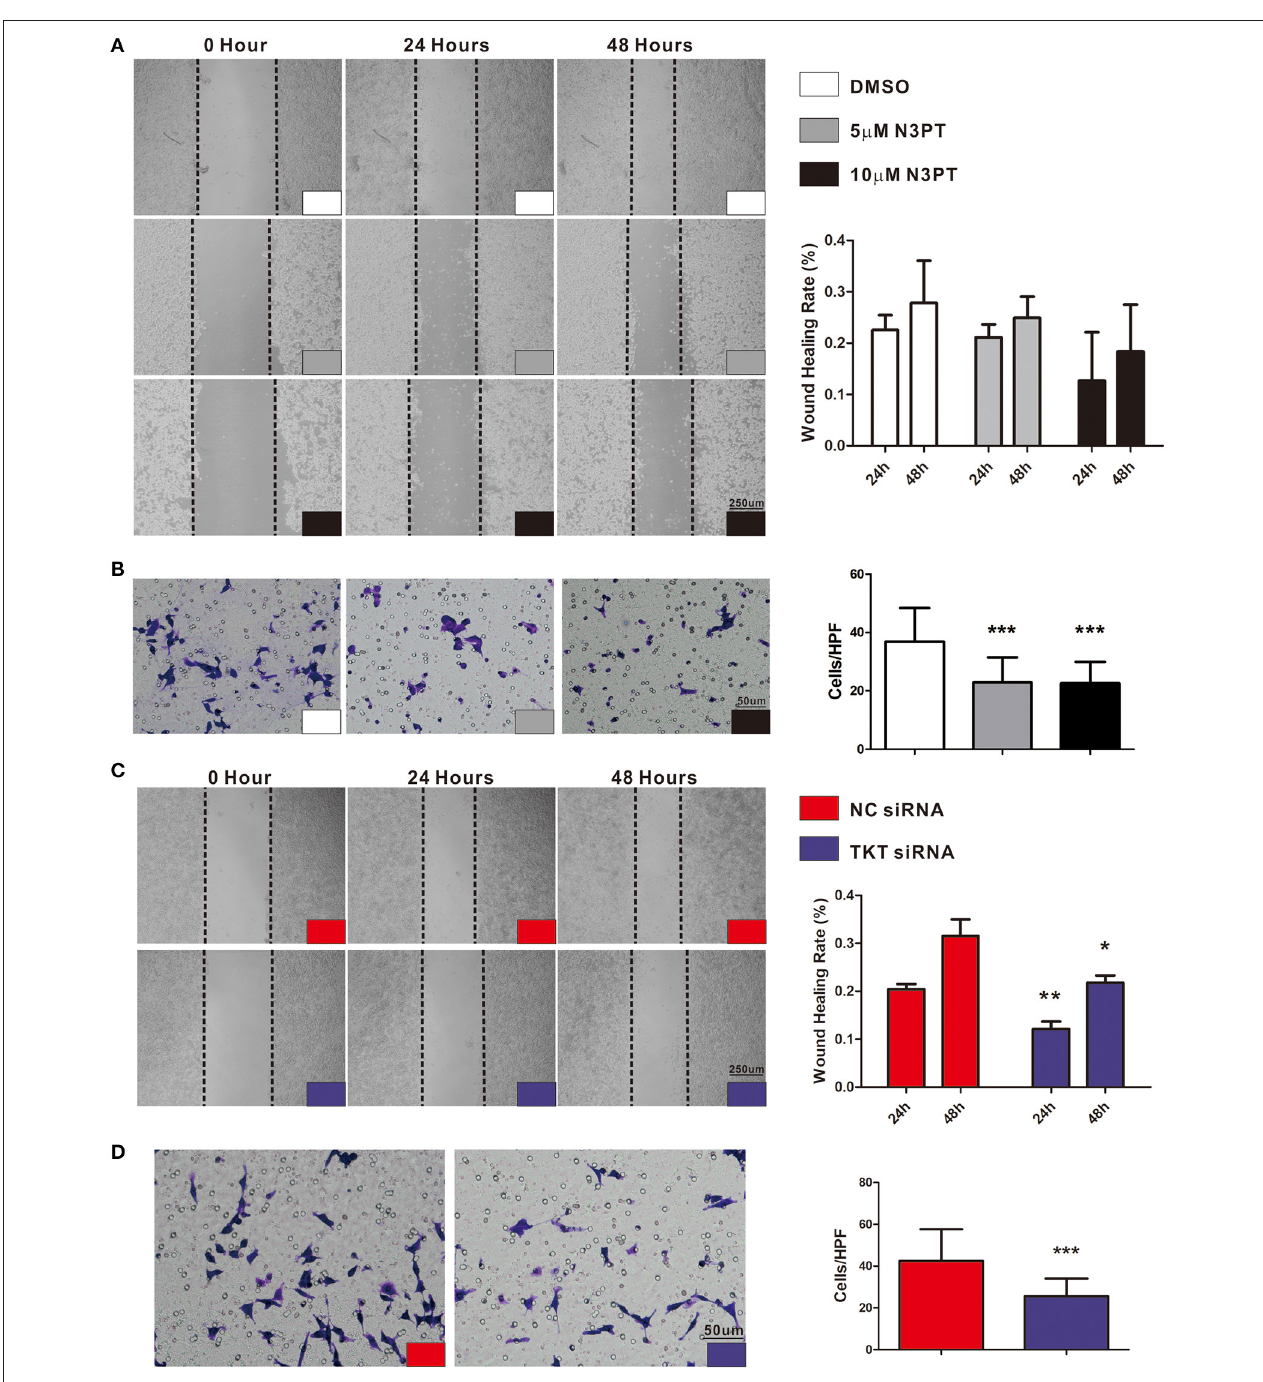
FIGURE 6 | Inhibition of TKT suppresses cell migration. (A,B) HCT116 cells were treated with DMSO or the TKT inhibitor N3PT (5 µ M or 10 µ M), and cell migration was assayed by wound healing assay (A) or Transwell assay (B) . The wound-healing assays showed no significant difference in the migration rate among the 5 µ M N3PT, 10 µ M N3PT and control groups. However, the migration rate was significantly decreased in the 5 µ M N3PT and 10 µ M N3PT groups in a Transwell assay. (C,D) HCT116 cells were transfected with TKT siRNA or negative control (NC siRNA), and cell migration was assayed by wound healing assay (C) or Transwell assay (D) . TKT siRNA transfected cells presented a significantly lower wound healing rate (C) and migration ability (D) than the NC siRNA-transfected cells. N = 3/group, * P < 0.05, ** P < 0.01, *** P < 0.001 vs. the control group.